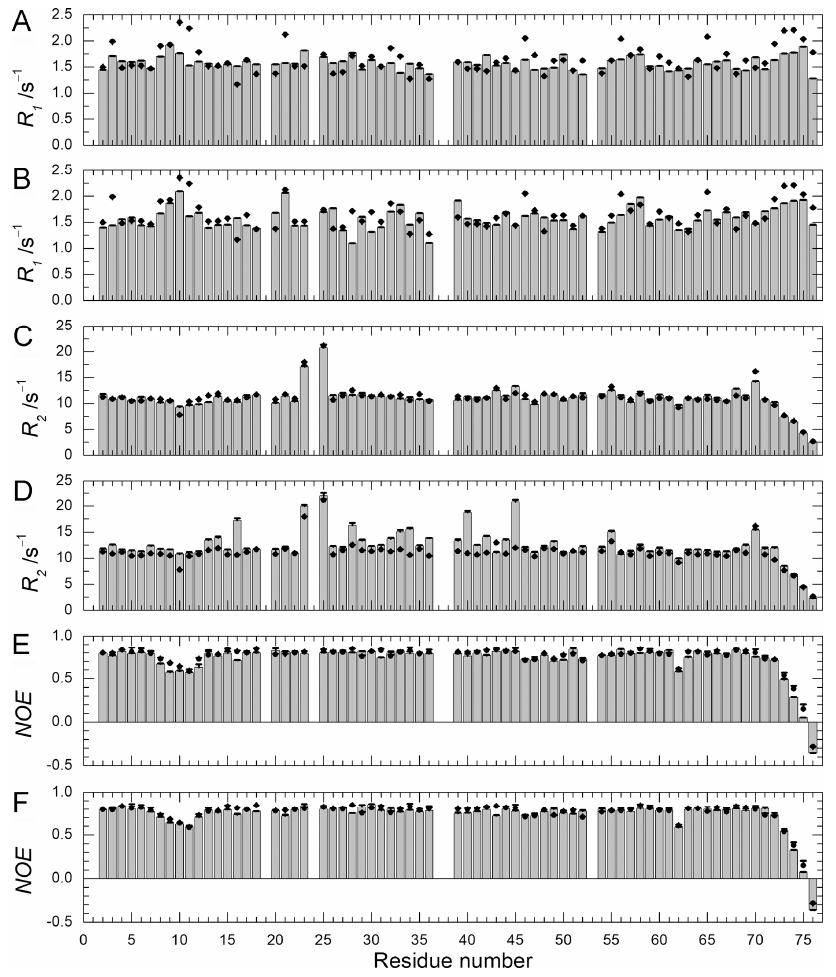
Figure 6. 15 N-spin relaxation dynamics of ubiquitin mutants (E34A and Q41N) (histograms) at 278 K. ( A ) 15 N-longitudinal relaxation rates, R 1 for E34A; ( B ) 15 N-longitudinal relaxation rates, R 1 for Q41N; ( C ) 15 N-transverse relaxation rates, R 2 for E34A; ( D ) 15 N-transverse relaxation rates, R 2 for Q41N; ( E ) Heteronuclear Overhauser effects, 15 N-NOE for E34A; ( F ) Heteronuclear Overhauser effects; 15 N-NOE for Q41N. Data for WT protein are represented by closed circles in each panel. American Chemical